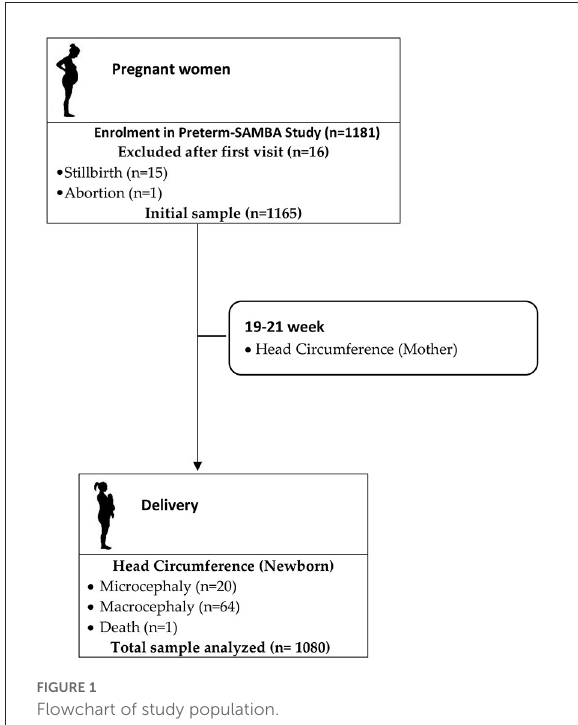
FIGURE1 Flowchart of study population.